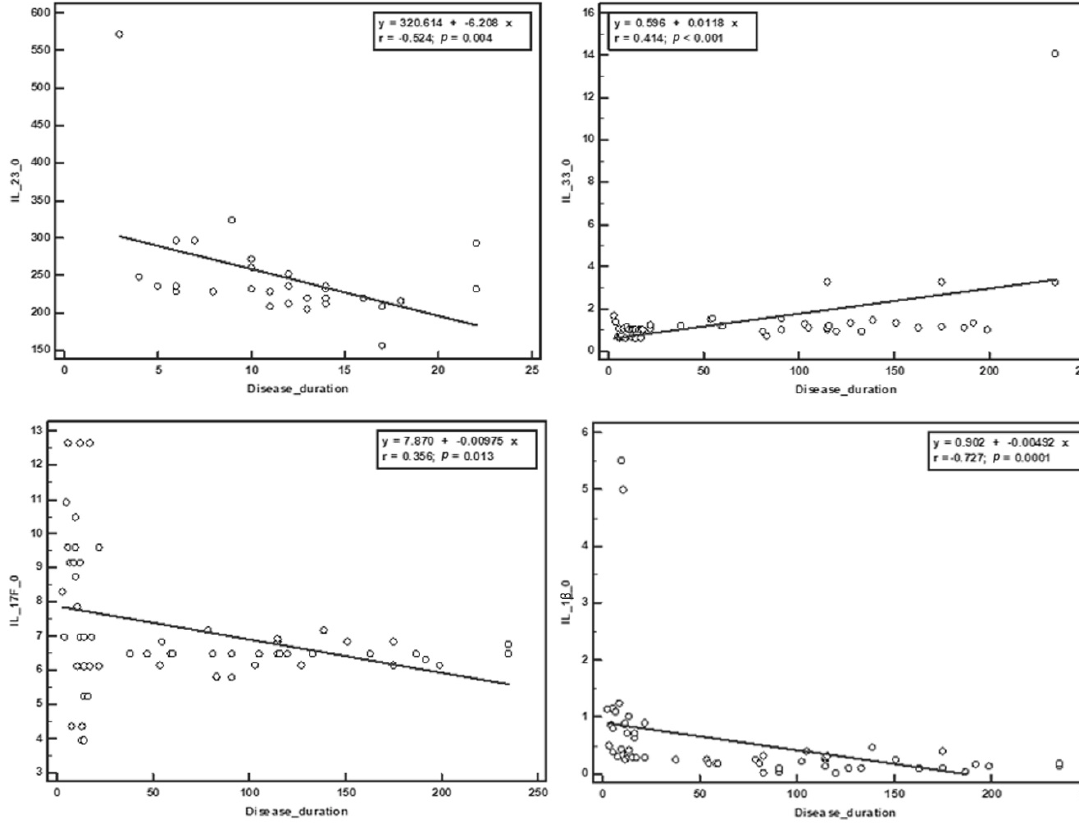
Figure 2. Correlations between the disease duration and the initial serum cytokine levels. Table 2. Correlations between serum cytokine values and clinical parameters. (Spearman correlation).